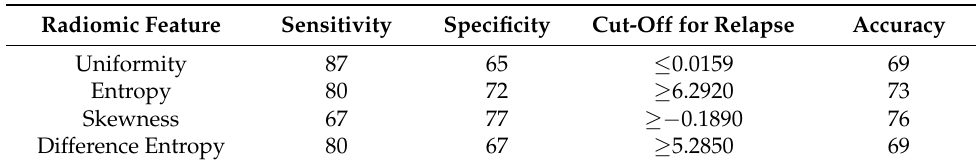
Table 3. Sensitivity, specificity, accuracy, and cut-off values of the radiomic features best-suited for outcome prediction.